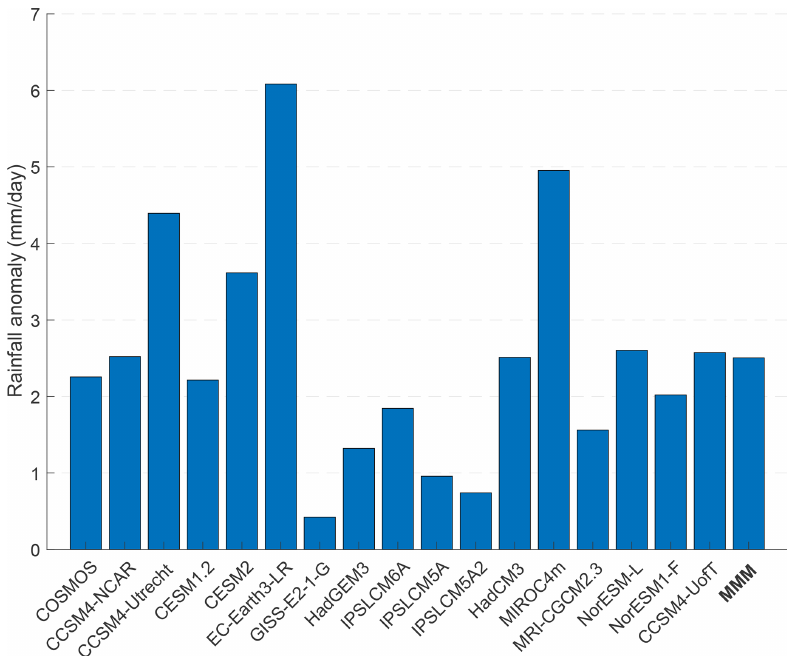
Figure 3. Mean July–October (JASO) Sahel (10–20 ◦ N, 20 ◦ W–30 ◦ E) mPWP rainfall anomaly (mPWP-PI, unit: mm/d) for the individual PlioMIP2 ensemble models, together with the